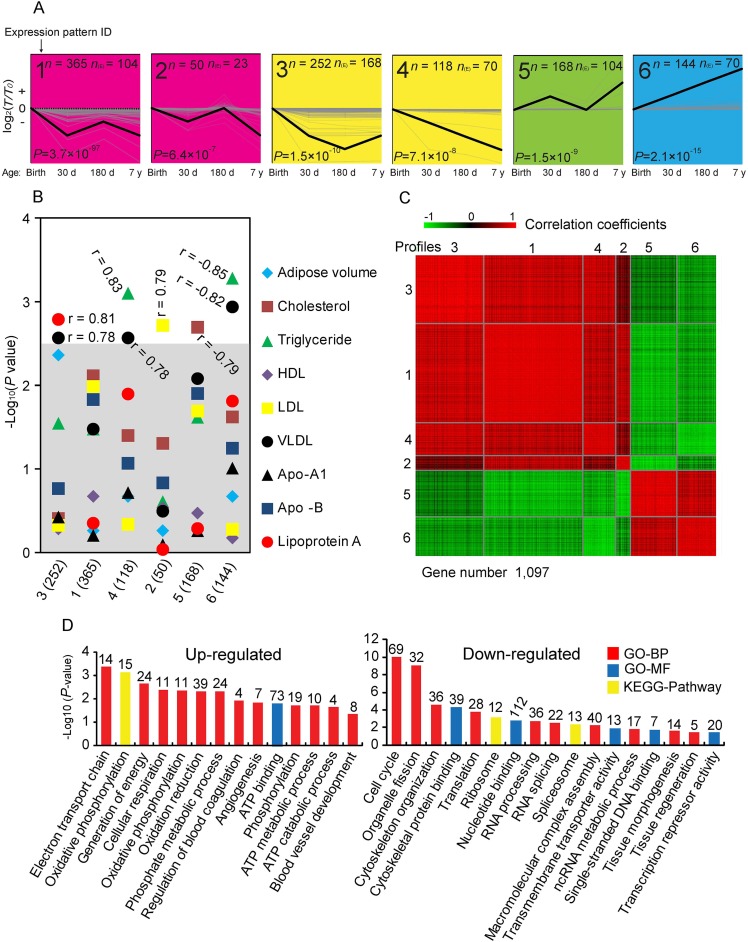
Analysis of short time-series expression cluster.(A) Six significant cluster profiles that have significantly more genes assigned under the true ordering of time points compared to the average number assigned to the model profile in the permutation runs (Non-significant cluster profiles are not shown). The upper left represents the serial number of the cluster, the lower left represents the P value (Fisher’s exact test), n represents the number of genes assigned, and n(E) represents the number of genes expected. Three other expressions were normalized to the highest one in four stages firstly, and then all expressions were log2-transformed. (B) Correlations between significant cluster profiles and phenotypic traits. −Log P values for Spearman correlation coefficients between the values of the profiles and the different phenotypic traits are shown. The gray shadow represents a highly stringent Bonferroni corrected P value of 0.05. (C) Heat map of significant cluster profiles. Gene pairs strongly positively or negatively correlated are shown in red or green, respectively. (D) Gene ontology (GO) categories enriched for up- and down-regulated genes involve in significant cluster profiles. The P value, which indicated the significance of the comparison, was calculated by Benjamini-corrected modified Fisher’s exact test. BP, biological process; MF, molecular function.